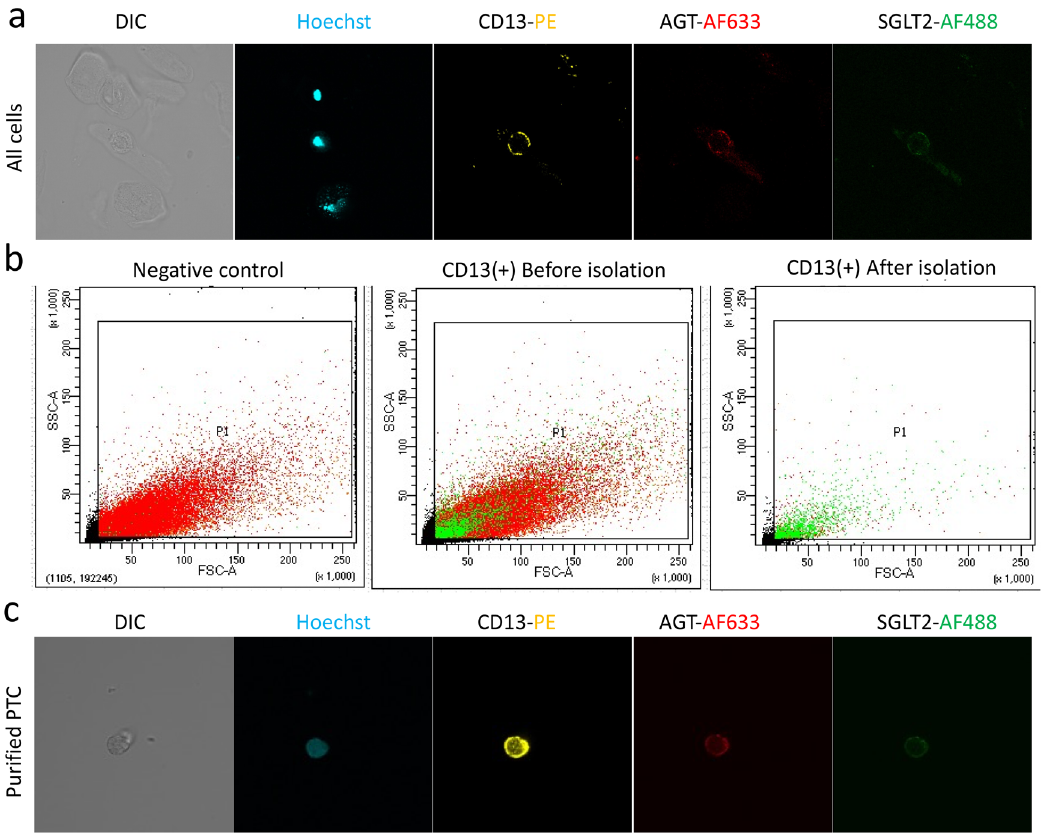
Figure 3. Urinary exfoliated cell characterisation before and after isolation ( a ) Immunofluorescence images showing only PTCs are positive for CD13, AGT and SGLT2; ( b ) Flow cytometry showing enrichment of CD13( +) cells before and after cell isolation; ( c ) Isolated cells have strong expression of PTC-specific markers.